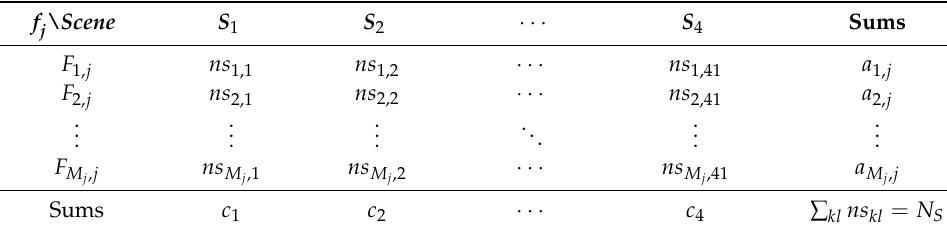
Table 4. Contingency table of f j and Scene